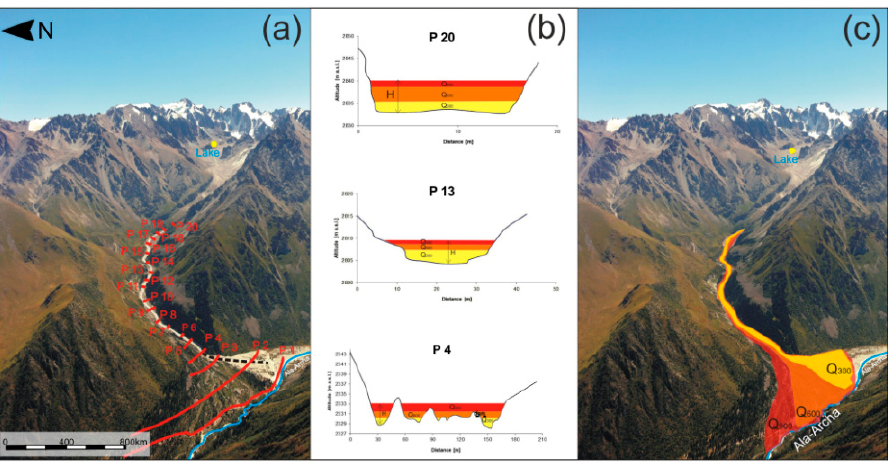
Figure 8. ( a ) Location of cross-section profiles P1–P20 across the Aksay Valley. ( b ) Selected representative cross-sections in the upper, middle, and lower part of the valley, showing modelled water height for each debris flow scenario: 300 (yellow), 600 (orange), and 900 m 3 s − 1 (red). ( c ) Potentially affected zones during a debris flow event according to the given scenario.